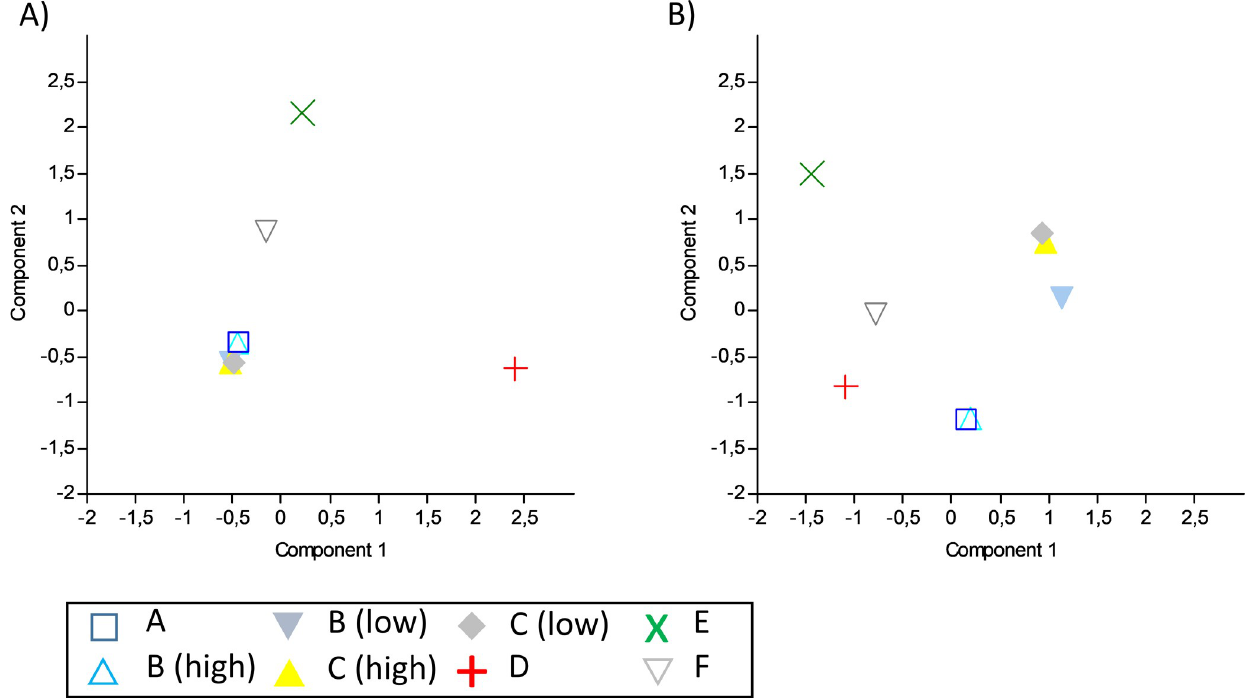
Fig 3. Principal component analyses (PCA) of all stations for A) mBRAVE and B) BLAST results. High and low tide sampling events are depicted separately for the respective stations. Stations A-C Elbe estuary, Station D Lake Eichbaum, Stations E and F Lake Hohendeich.